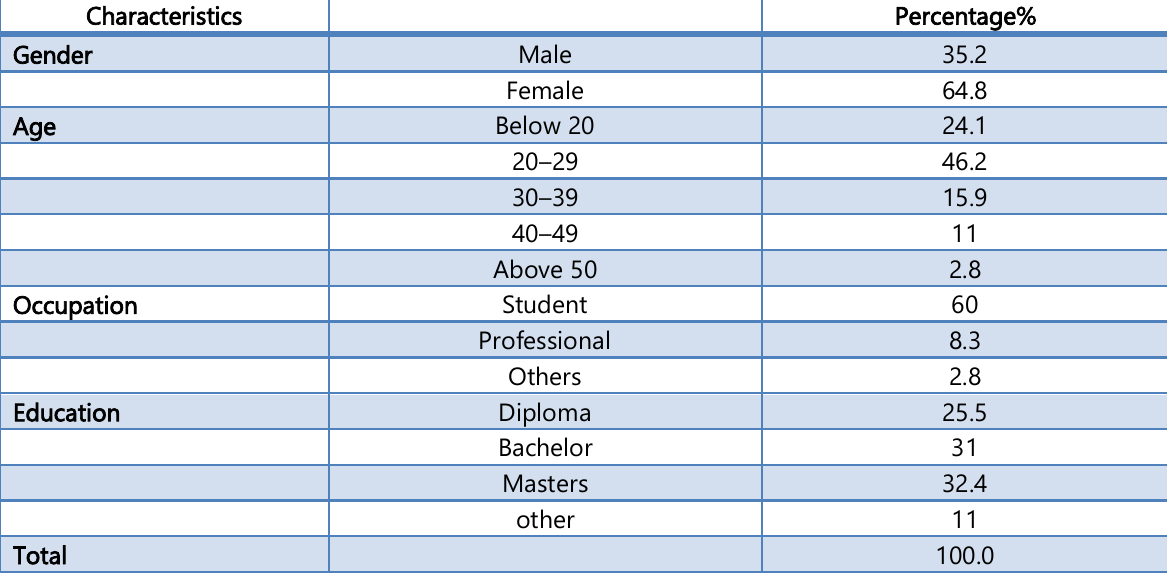
Table 1: Demographic Information of Respondents (Source: Authors‘ depiction) Characteristics